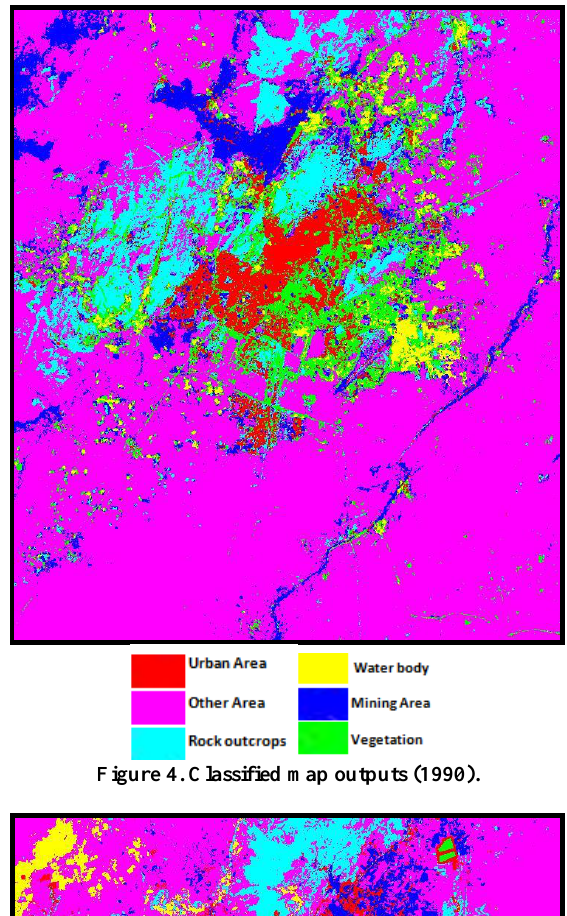
Figure 4. Classified map outputs (1990).